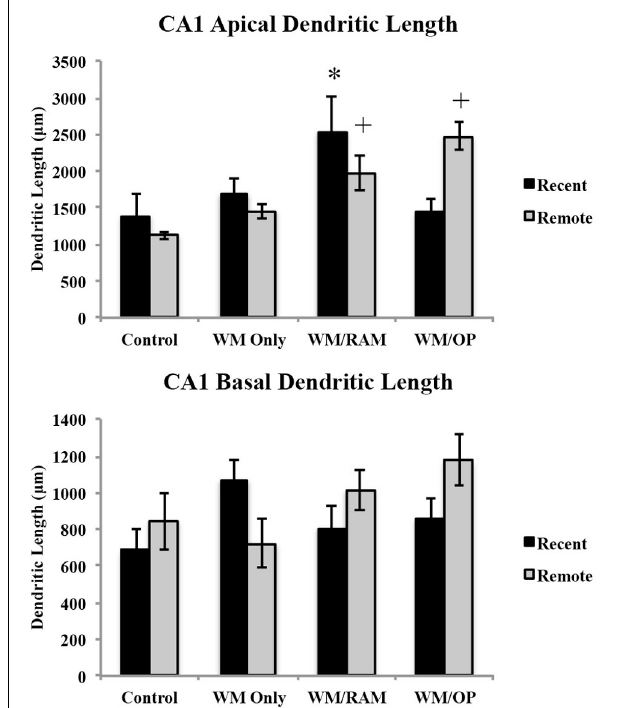
FIGURE 9 | Total number of branches in the CA1 in apical and basal dendrites. Only significant differences between behavioral groups and their respective control group are displayed. Refer to Results section for all comparison results. ∗ Significantly different from Control:recent group ( p < 0 . 05); + Significantly different from Control:Remote ( p < 0 . 05).